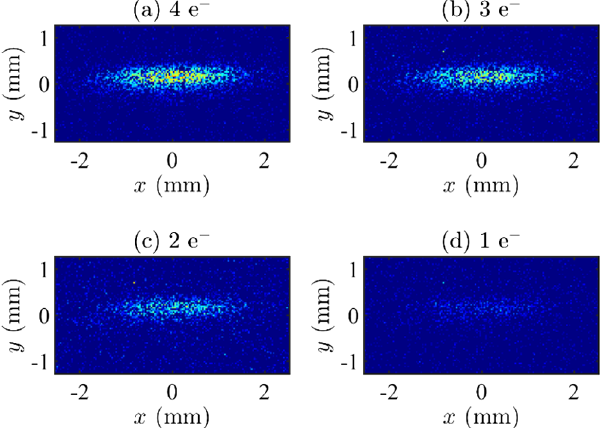
FIG. 4. A set of four CMOS camera 2D images with 10-s sensor integration times. They are background subtracted for the four stored-electron number indicated, 4 to 1. This is at 375 MeV.